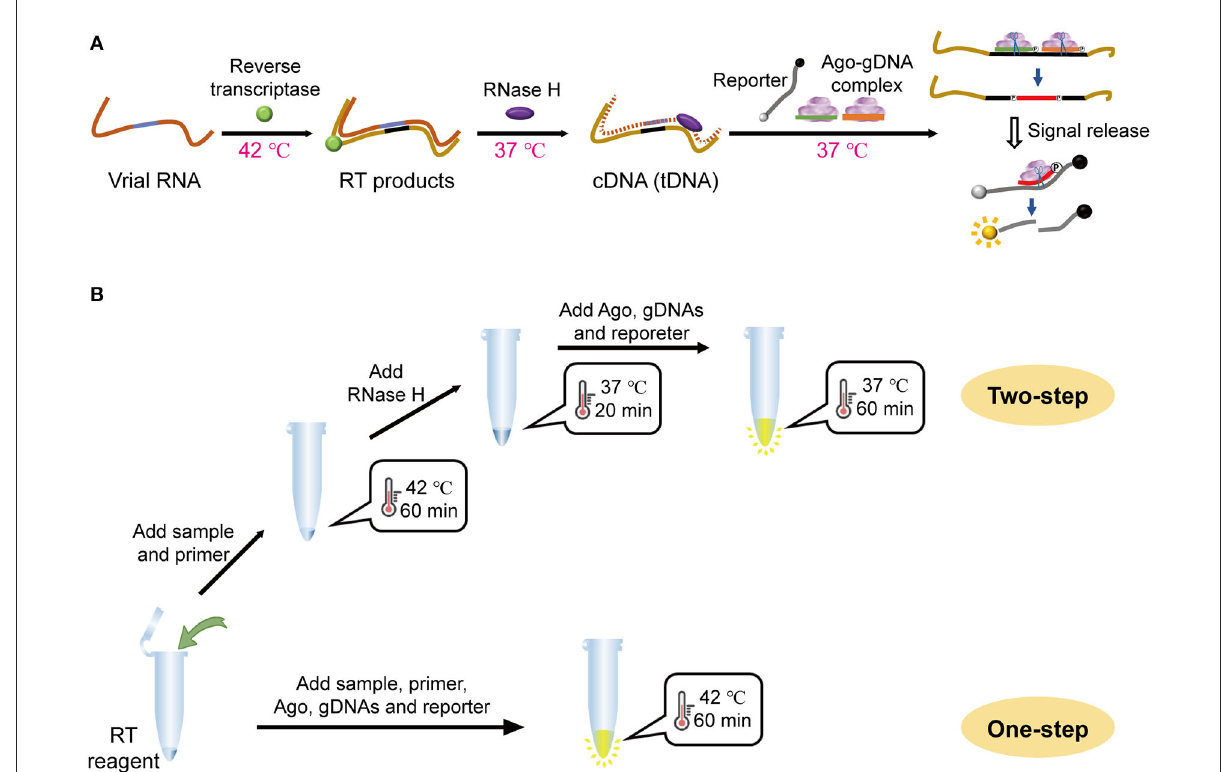
FIGURE1 Workflow of the MAIDEN system. (A) Schematic illustration of the enzymatic process of mesophilic Ago-based diagnostics for RNA viruses. (B) Schematic diagram of the procedure for the two-step operation and the one-step